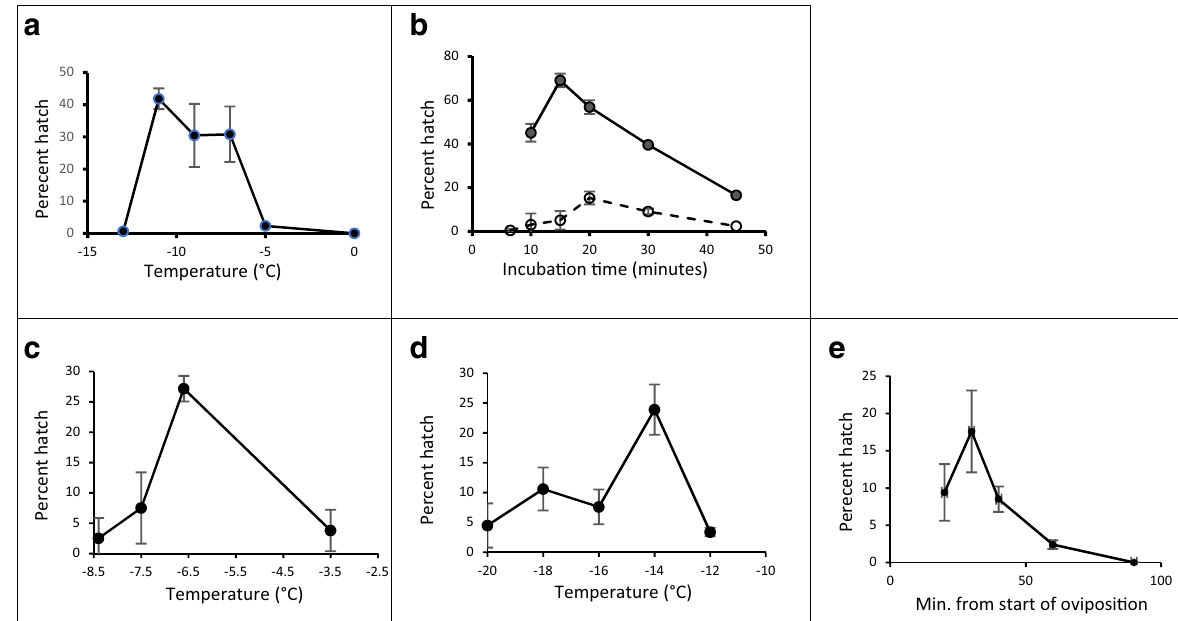
Figure 1. Parameters for oviposition and incubation in cryoprotectant additive (CPA: methanol) for A. stephensi egg cryopreservation. ( a ) Survival (percent hatch) of eggs following incubation in 100% methanol for 15 min at temperatures between 0 and − 13 °C without subsequent cooling and with recovery into water at 23 °C. ( b ) Survival (percent hatch) of eggs following incubation in 100% methanol for periods of 7–45 min at − 11 °C and subsequent dilution into water at 23 °C. Eggs directly warmed/diluted from − 11 °C without being rapidly cooled by plunging into LN 2 (solid line); eggs incubated at − 11 °C and subsequently plunged into LN 2 before warming/dilution (dashed line). ( c ) Optimization of the incubation temperature for the first CPA incubation step with the second incubation step held constant at − 14.5 °C for 15 min. ( d ) Optimization of the incubation temperature for the second CPA incubation step with the first incubation step held constant at − 7 °C for 6.5 min. ( e ) Effect of oviposition time on survival: eggs were oviposited onto water in Petri dishes for 15 min, harvested and then held an additional 5–75 min before adding to CPA (single incubation at − 11 °C for 15 min). The data points represent the age of the oldest eggs in each sample (20–90 min